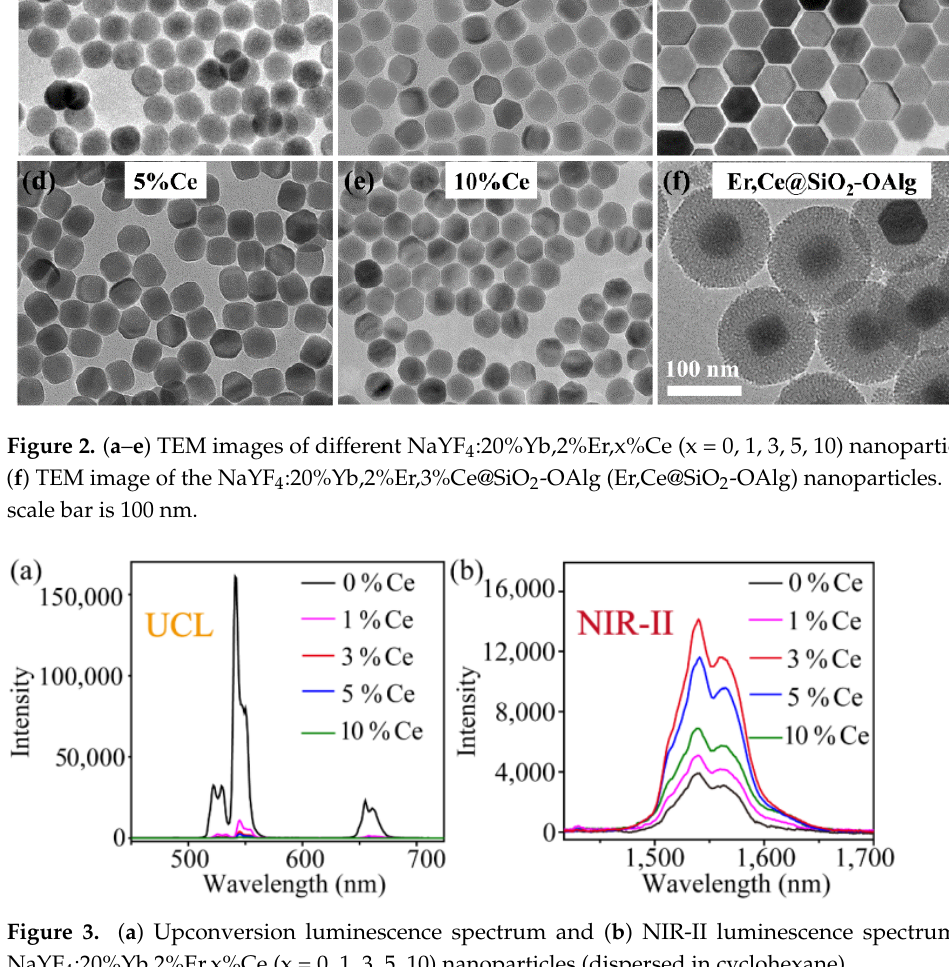
Figure 2. ( a – e ) TEM images of different NaYF 4 :20%Yb,2%Er,x%Ce (x = 0, 1, 3, 5, 10) nanoparticles. ( f ) TEM image of the NaYF 4 :20%Yb,2%Er,3%Ce@SiO 2 -OAlg (Er,Ce@SiO 2 -OAlg) nanoparticles. The scale bar is 100 nm.